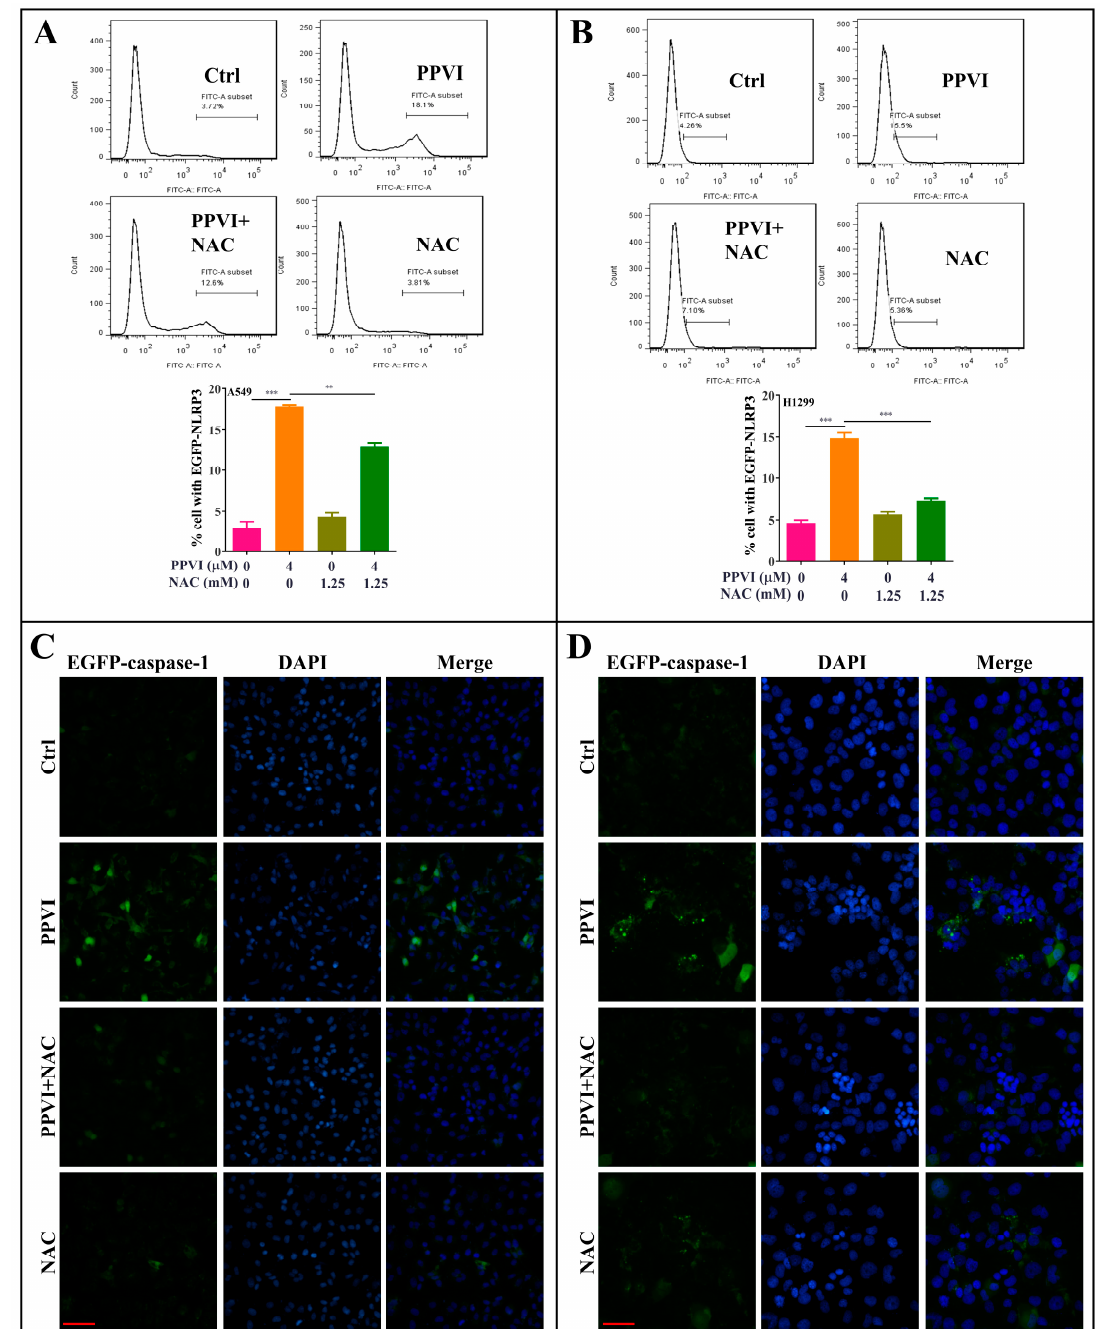
Figure 9. NAC inhibits the expression of NLRP3 and caspase-1 in PPVI treated A549 cells and H1299 cells. A549 cells ( A ) and H1299 cells ( B ) transiently transfected with EGFP-N1-NLRP3 plasmid for 24 h, treated with PPVI or co-treated with NAC and PPVI, at indicated concentrations, for another 24 h. After treatment, the cells were trypsinzed and collected for the analysis of fluorescence intensity by flow cytometry. Bar chart indicates the percentage of cells with GFP signal in A549 and H1299 cells; bars, S.D. ** p ≤ 0.01; *** p ≤ 0.001. A549 cells ( C ) and H1299 cells ( D ) transiently transfected with EGFP-N1-caspase-1 for 24 h were treated with PPVI or co-treated with NAC and PPVI at indicated concentrations for another 24 h. After treatment, the cells were fixed with 4% PFA, and the representative images were captured using the fluorescence microscope. Magnification: 40×. Scale bar: 25 µm.